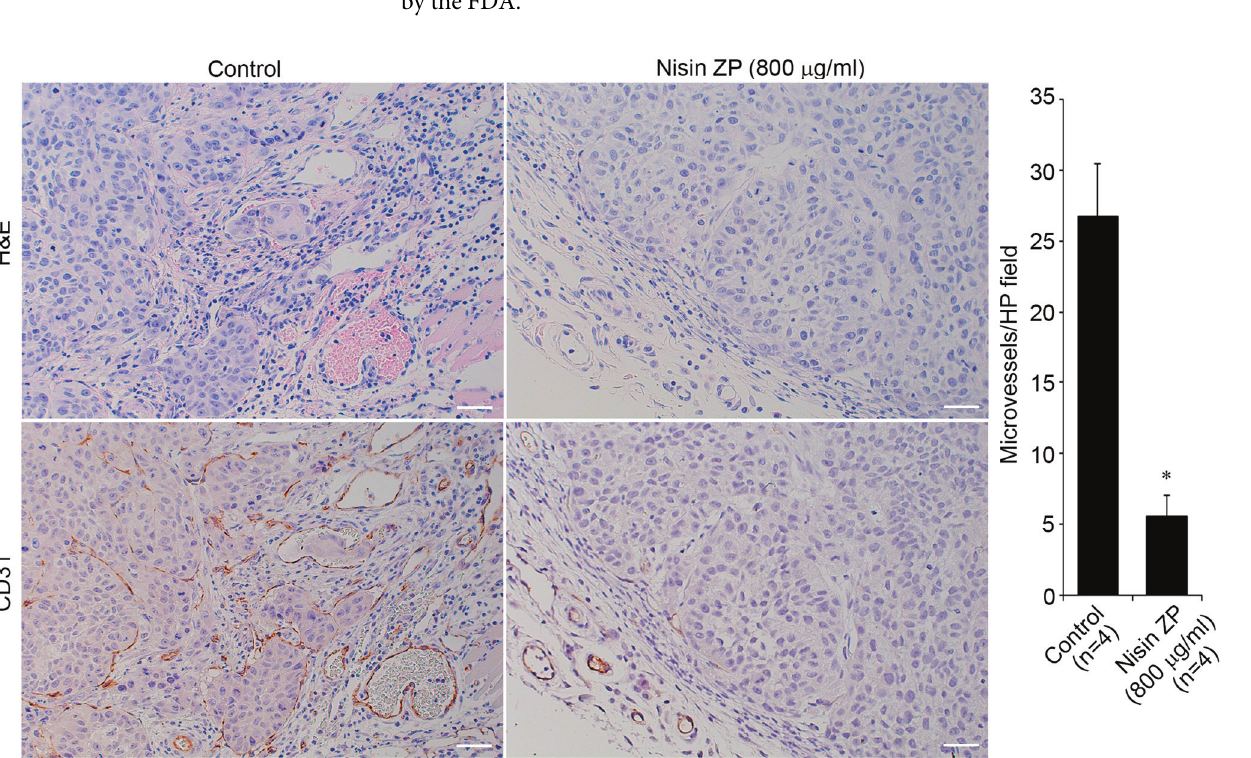
respectively [36]. Thus, a theoretical therapeutic dose for nisin (66.7 mg/kg) in humans would be approximately twice that already present in some foods (37.5/mg/kg). In addition, this dose does not approximate the reported toxic doses in rodents and is within the NOEL designation by the FDA.